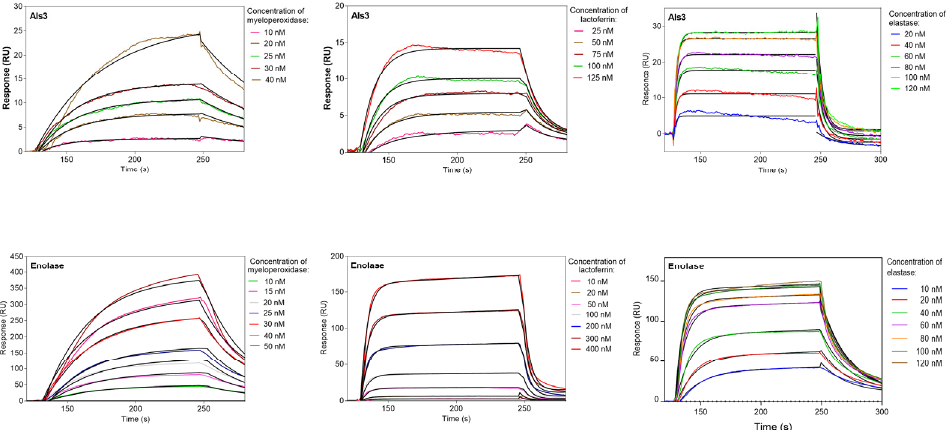
Figure 5. Binding of selected NET-composing proteins to immobilized fungal cell surface proteins—Als3 and enolase. The kinetic analysis of the binding properties of selected fungal proteins was performed using a BIACORE 3000 system with the detection of surface plasmon resonance changes (RU) during the NET-protein binding to the immobilized Als3 and enolase on the surface of CM5 chips. For the protein immobilization, the standard amine-coupling procedure was used. The immobilization level was 800 RU and 400 RU for Als3 and enolase, respectively. The selected host protein solutions were injected over the chip surface with a flow rate of 30 µ L/min, for 2 min for association and 2 min for dissociation processes. For the chip surface regeneration, a pulse of 1 M NaCl (30 s) or 0.1% of SDS (10 s) was used, according to the manufacturer-recommended procedure. The data from three independent tests were analyzed by BIAevaluation software version 4.1 (GE Healthcare). For each dataset, the simultaneous fitting of constants for association and dissociation rates was used with the 1:1 Langmuir binding model.